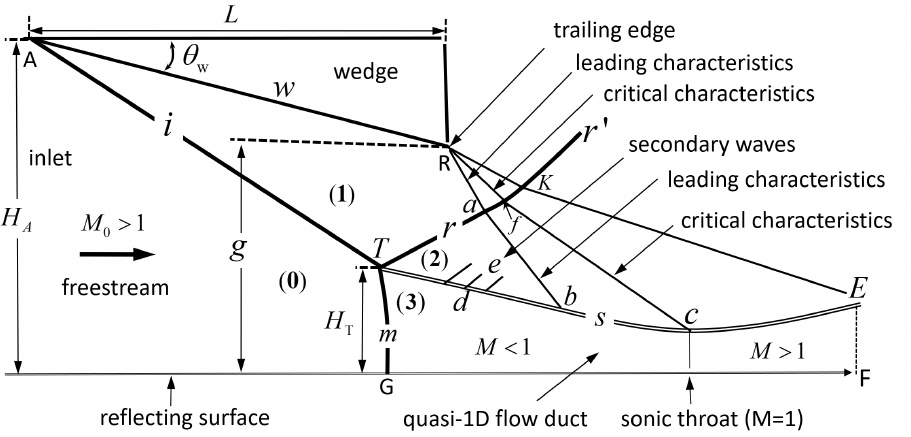
Figure 1. Mach reflection configuration. The inflow Mach number M 0 , the wedge angle θ w , the inlet height H A and the lower wedge surface length w or the trailing edge height g are given